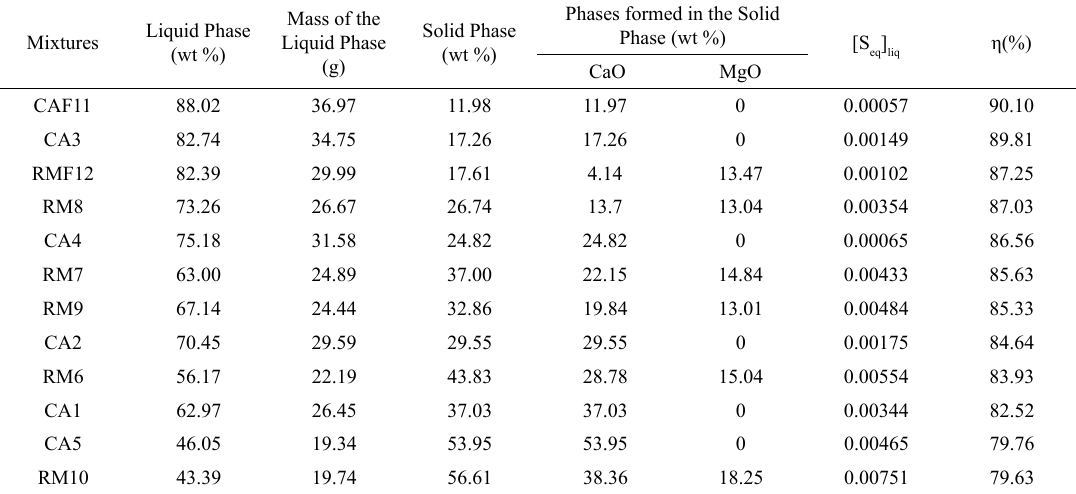
Table 5. Equilibrium calculations from initial mixtures of cast iron via Thermo-Calc ® .